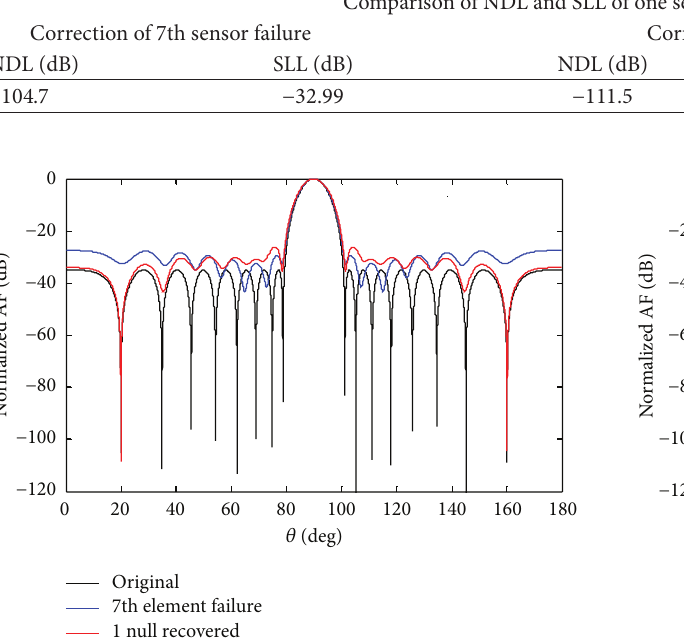
Table 3: Recovery of one null.